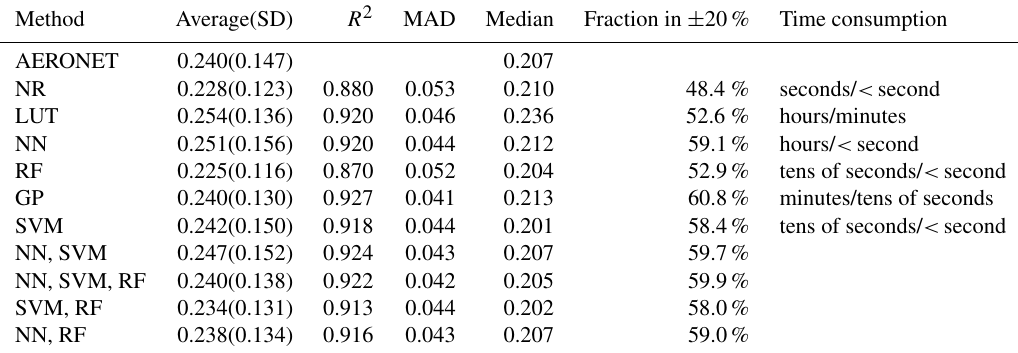
Table 1. Statistical characteristics of observed (AERONET) and predicted AOD by the methods of NR (non-linear regression), LUT (look-up table), NN (neural network), RF (random forest), GP (Gaussian process), SVM (support vector machine) and some of their combinations (averages without weights, e.g. NN, SVM combination is their average result). Correlation coefficient ( R 2 ) , mean absolute deviation (MAD), median and their ± 20% percentiles between the observed and predicted. Time consumptions with a recent average computer power of the methods for training/estimation in the magnitude of seconds, minutes and hours. The number of observations is